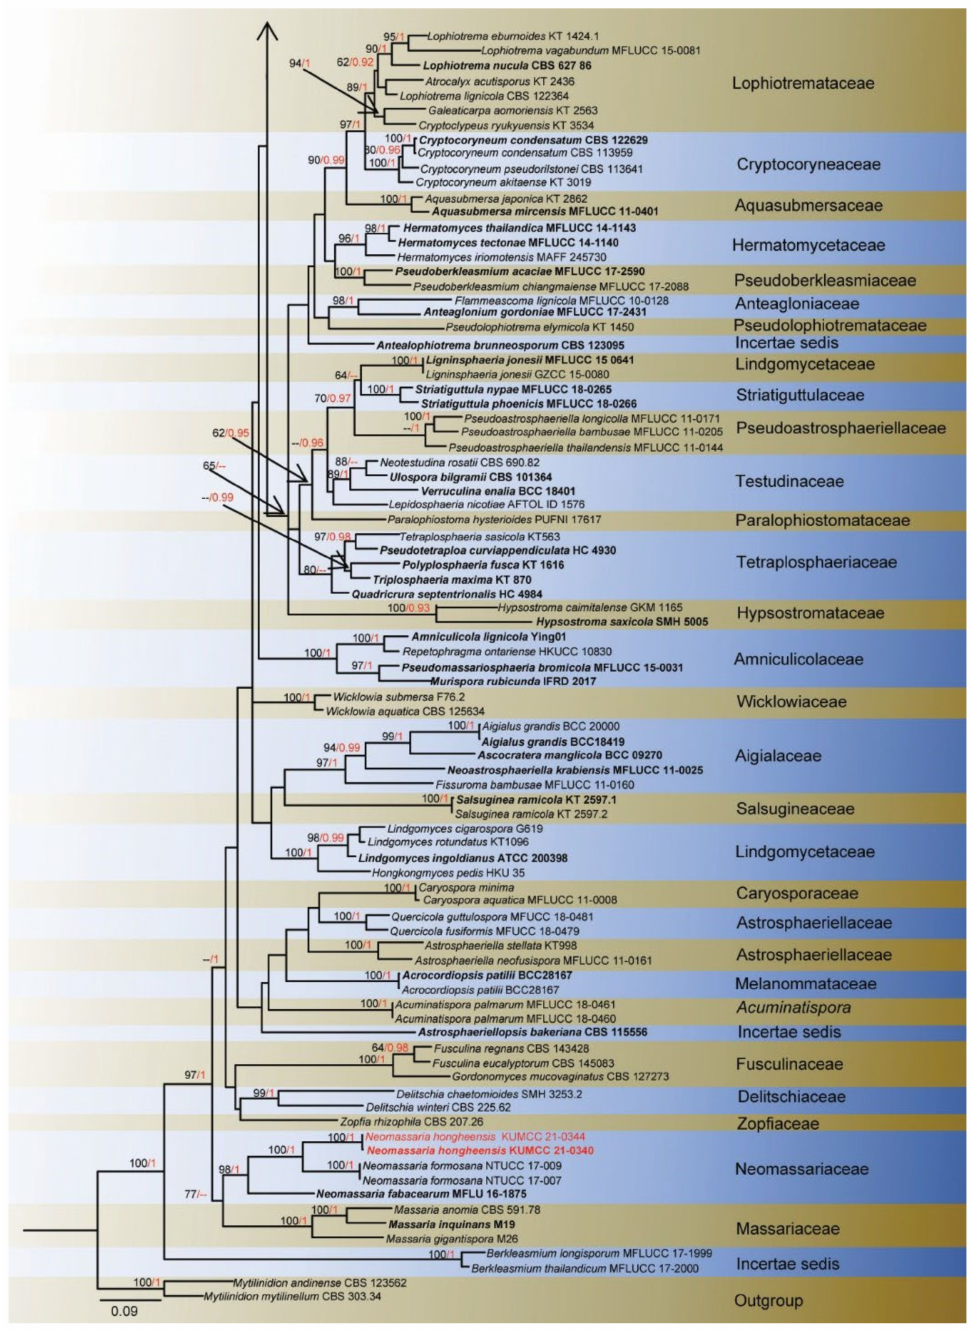
Figure 5. Phylogram generated from maximum likelihood analysis based on a combined LSU, SSU, rpb2 , tef1- α , and ITS sequence datasets. Related sequences were taken from Zhang et al. [24], Ariyawansa et al. [30], and Hongsanan et al. [81]. The 180 strains are included in the combined gene analyses’ 4531 total characters, including gaps (LSU: 1–880 bp, SSU: 881–1913 bp, tef1- α : 1914–2840 bp, rpb2 : 2841–3878 bp, ITS: 3879–4531), Tree topology of the ML analysis was similar to the BI. The matrix had distinct alignment patterns, with the final ML optimization likelihood value of − 117,367.689956 (ln). All free model parameters were estimated by RAxML model, with 2953 distinct alignment patterns and 32.22% undetermined characters or gaps. Estimated base frequencies were as follows: A = 0.247310, C = 0.247387, G = 0.270304, T = 0.234998, with substitution rates AC = 1.384565, AG = 3.688216, AT = 1.401064, CG = 1.072637, CT = 7.214852, GT = 1.000000. The gamma